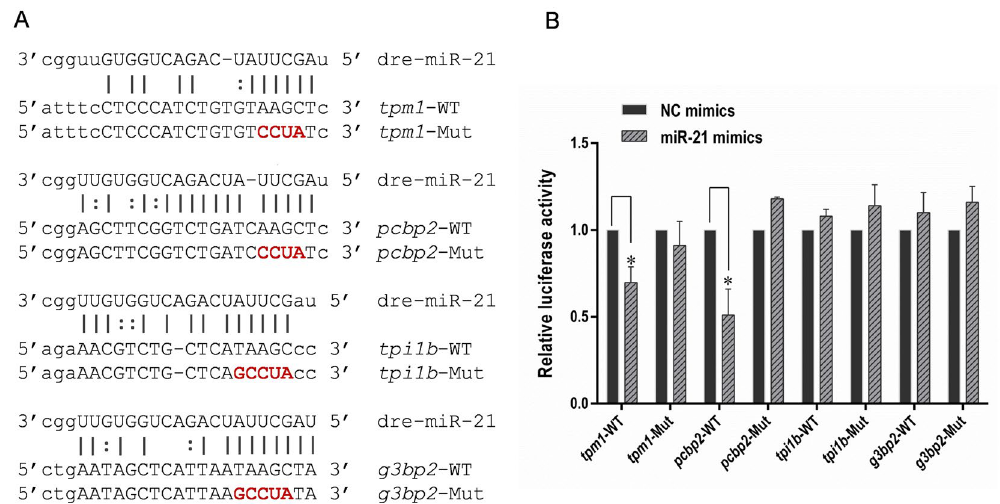
Figure 6. Validation of candidate miR-21 target genes. ( A ) Putative miR-21-binding sites within the 3 ′ -UTRs of tpm1 , pcbp2 , tpi1b and g3bp2 genes. Perfect matches are indicated by a line, and G:U pairs by a colon. Nucleotides mutated for the reporter gene assays are underlined. ( B ) Activity of luciferase reporters